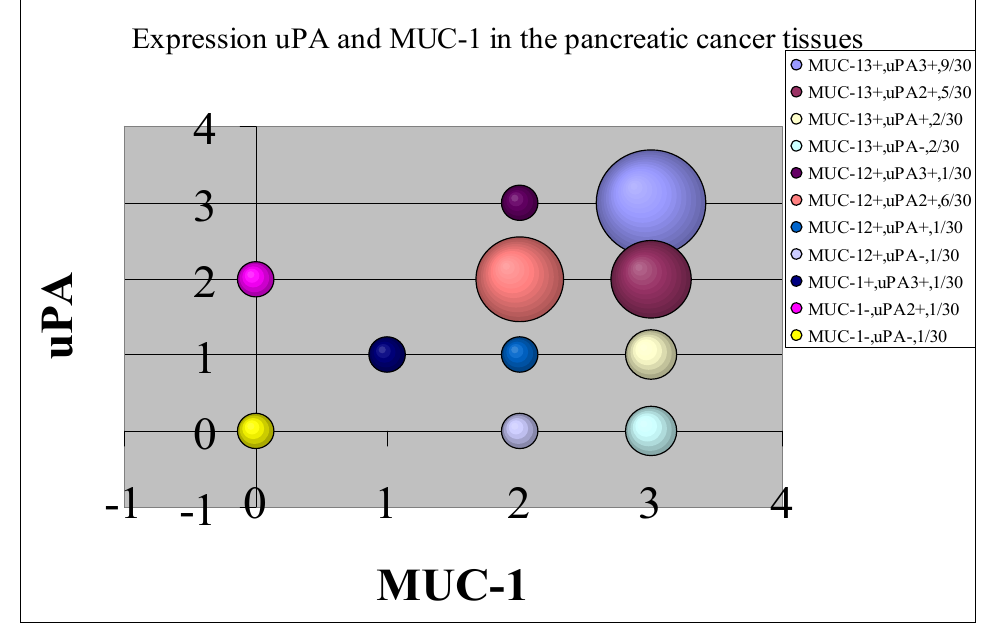
Figure 3. Correlation between the expression of the MUC1 and uPA receptors. Expression uPA and MUC-1 in the pancreatic cancer